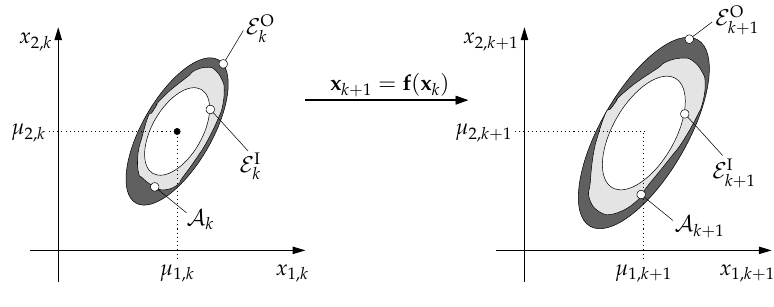
Figure 1. Definition of a thick ellipsoid (( E )) model